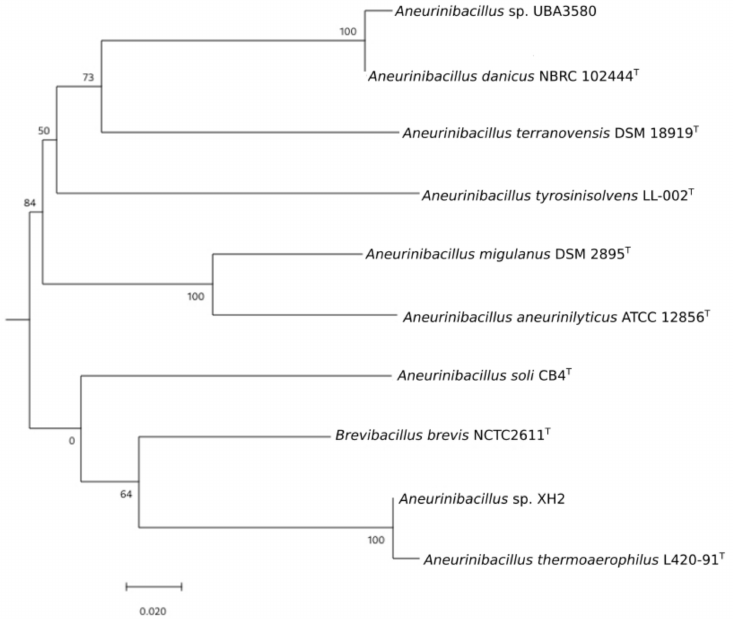
Figure 1. Phylogenomic tree of all Aneurinibacillus strains used in this study. The branch lengths are scaled in terms of GBDP distance formula d5 . The numbers above branches are GBDP pseudo- bootstrap support values >60% from 100 replications, with an average branch support of 81.6%. The genome of Brevibacillus brevis NCTC 2611 T was used as an out-group.